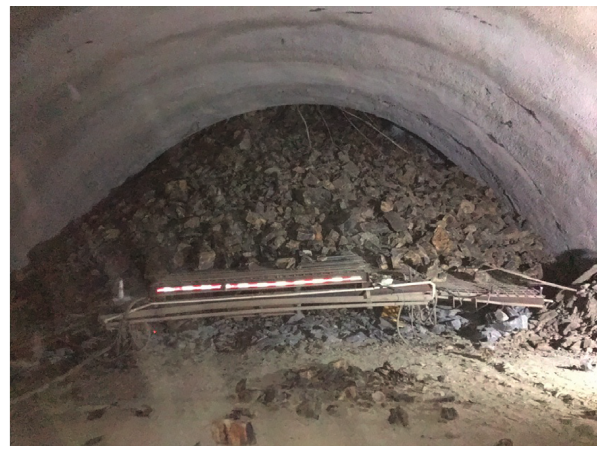
Figure 1: Collapse of the roof induced by a karst cave located above a highway